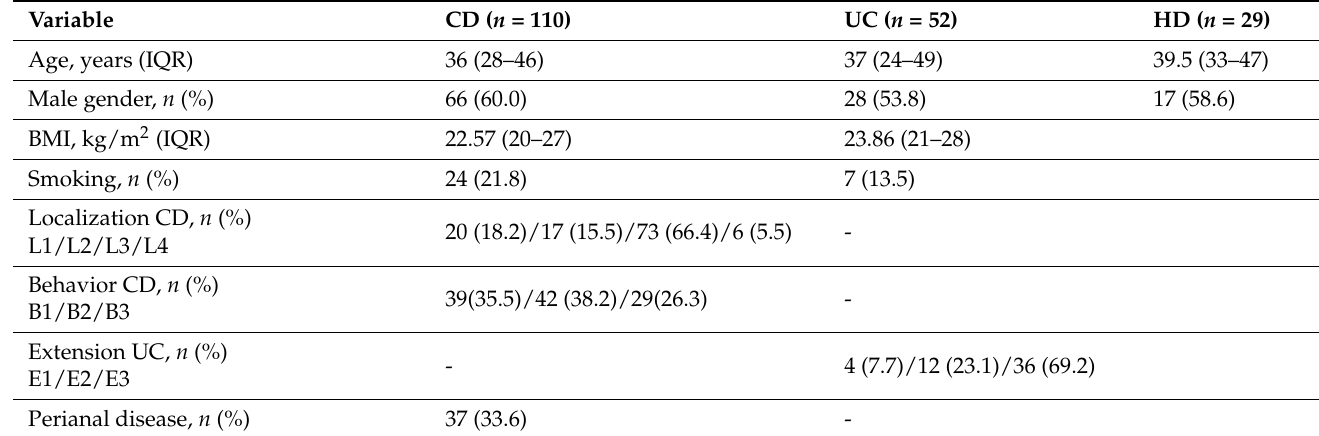
Table 2. Demographic characteristics of patient populations and healthy